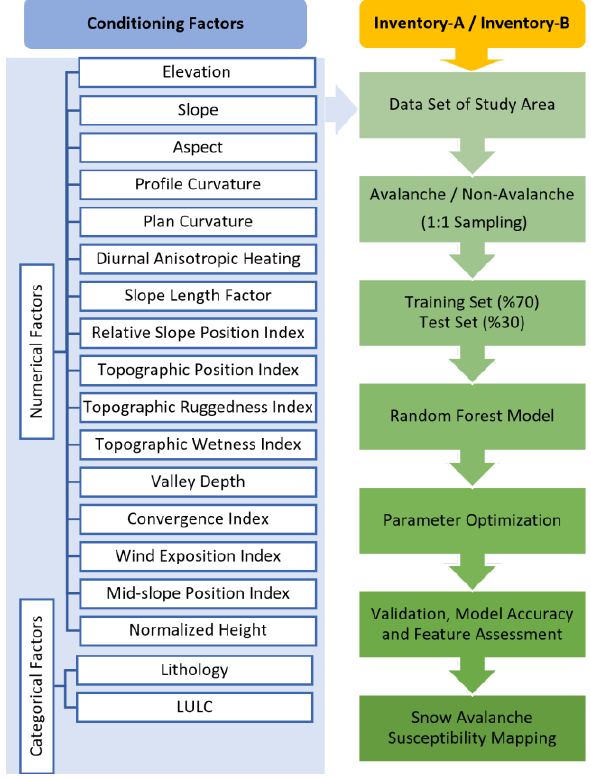
Figure 2. Snow avalanche susceptibility mapping